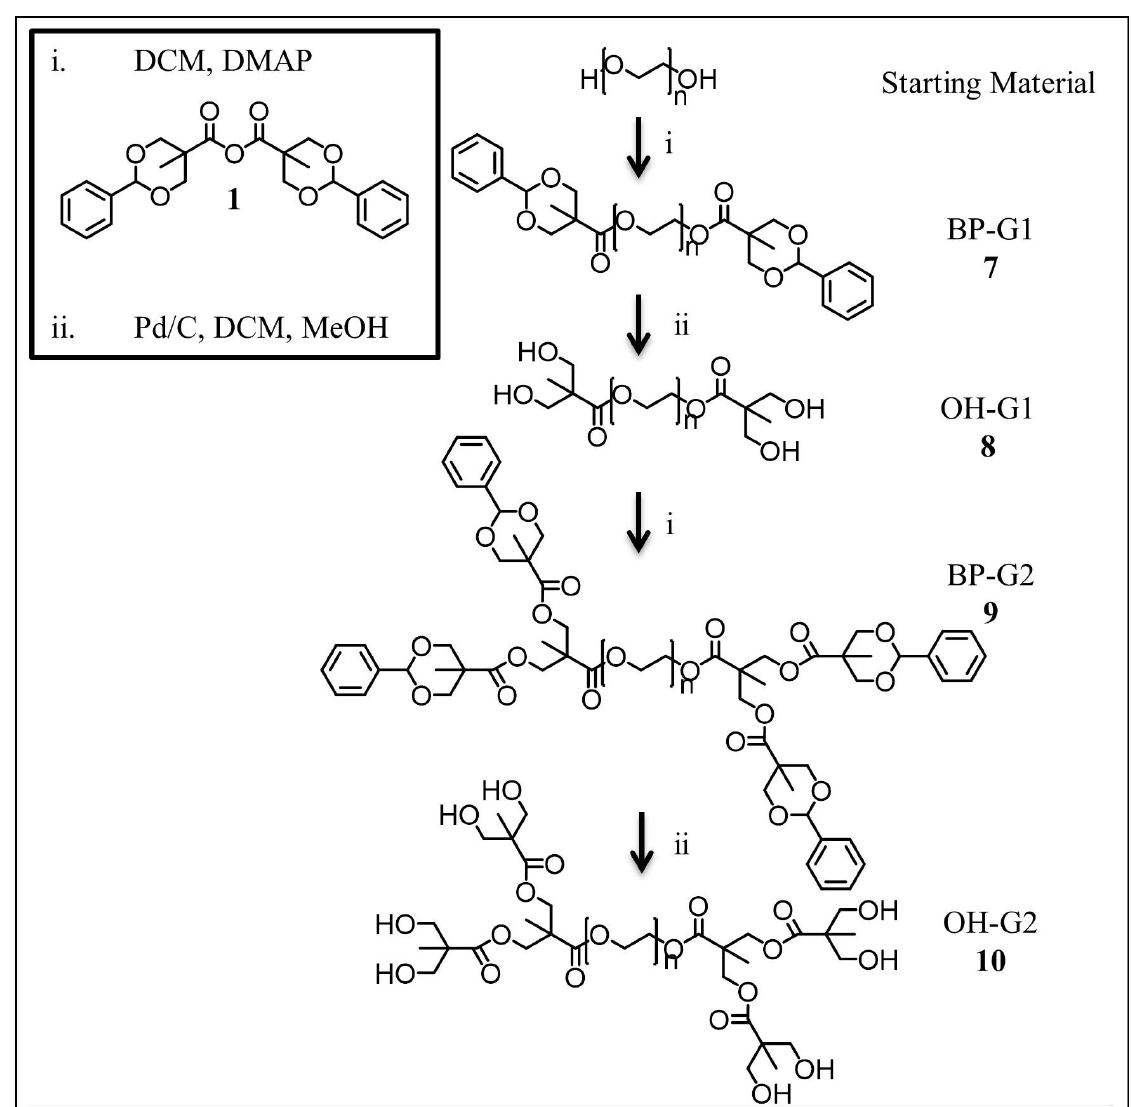
FIGURE 2 - Synthesis of dendritic-linear-dendritic triblock via divergent dendronization of dihydroxy PEG.